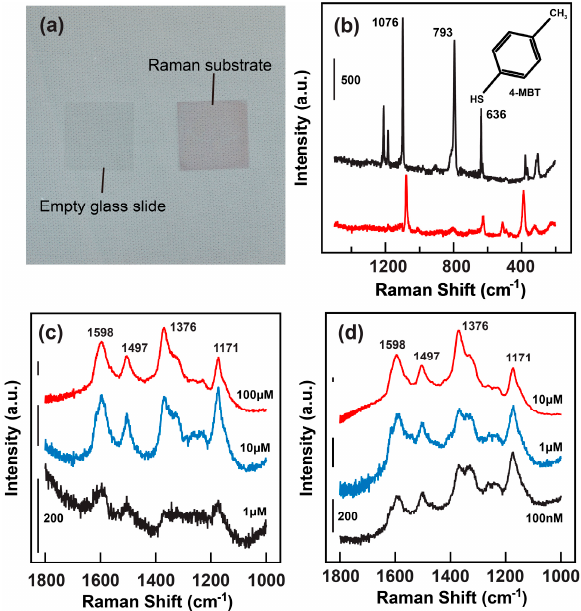
Figure 3. SERS activity of the large-aspect-ratio gold nanorods. ( a ) Digitial photograph of the SERS substrate fabricated with glass slide. ( b ) Raman spectra of the 4-MBT on the SERS substrate (red) and in powder form (black). The molecular formula of the 4-MBT is presented in the inset. The spectrum of the molecular powder was collected using a laser power of 118.00 mW, while that from the SERS substrate was collected with a power of 1.37 mW. ( c , d ) Raman spectra of the PANI-ES on the pristine glass substrate and SERS substrate. The baselines of the Raman spectra have been modified for clear demonstration of the data.